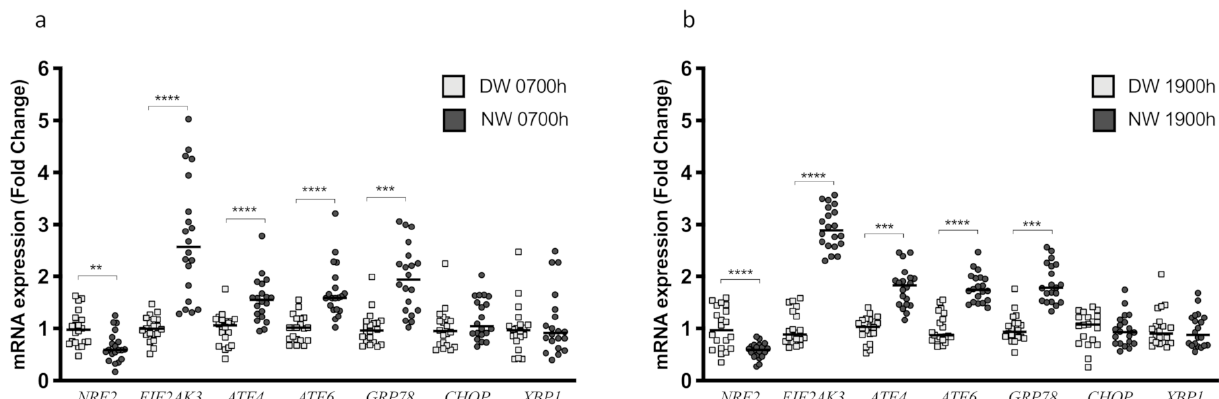
Figure 5. Determination of the expression of genes related to endoplasmic reticulum stress in PBMC samples of day and night workers at 0700 h and 1900 h. ( a ) Graph representing diurnal variations in gene expression of genes related to endoplasmic reticulum stress (ERS). The data were normalized by day workers (DW) 0700 h. ( b ) Graph representing the nocturnal variations of gene expression of genes related to ERS. The data were normalized by DW 1900 h. Gene expression was evaluated by RT-qPCR ( n = 20 per group). Data are presented as dot plot with mean. Unpaired, one-tailed t -test. ** p < 0.01, *** p = 0.001, **** p <